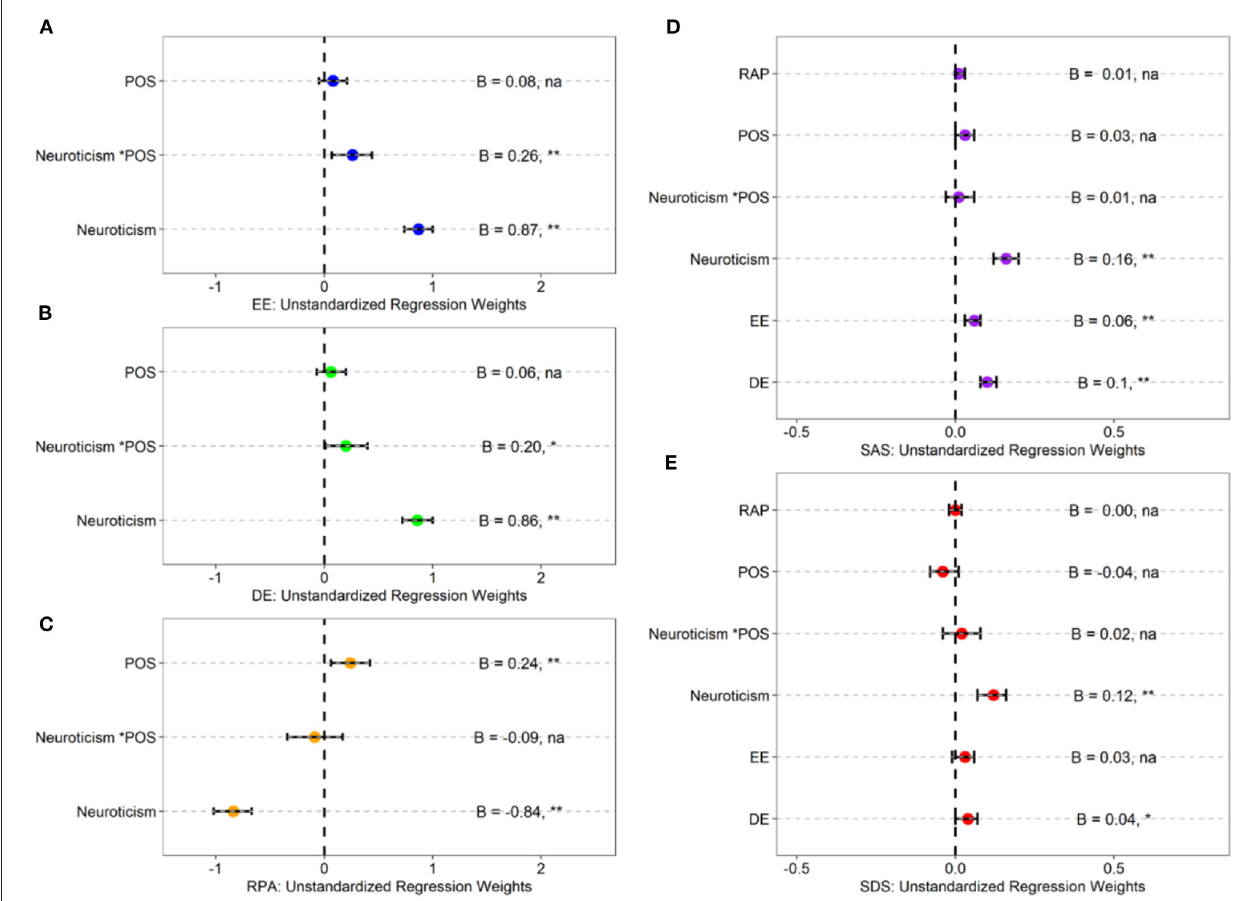
FIGURE 1 | Unstandardized regression coefficients of the hypothesized model ( N = 716). POS, perceived organizational support; EE, emotional exhaustion; DE, depersonalization; RPA, reduced personal accomplishment. (A) Indicates model 1. (B) Indicates model 2. (C) Indicates model 3. (D) Indicates model 4. (E) Indicates model 5. * indicates p < 0.05; ** indicates p < 0.01; na indicates p > 0.05.